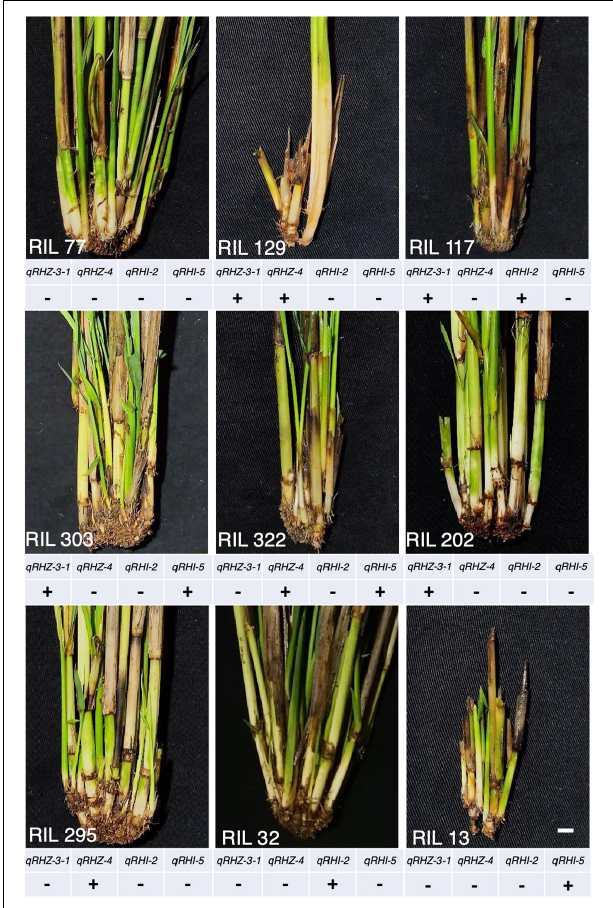
FIGURE 7 | Phenotypes of representative rhizome-free RILs. “+” and “–” represent O. longistaminata and RD23 homozygous alleles at the locus,